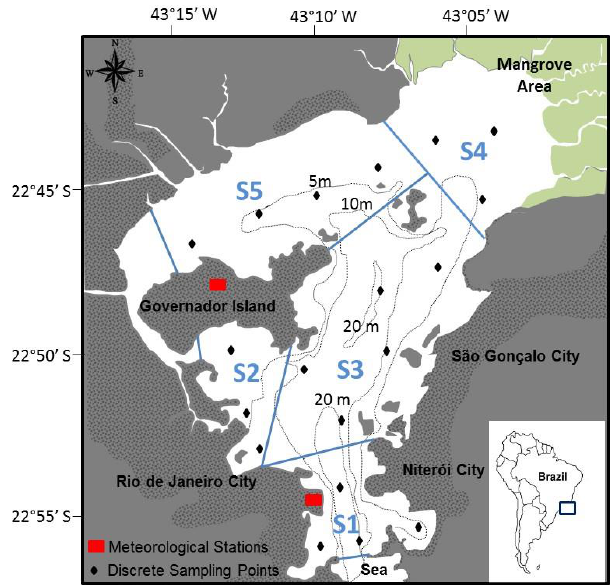
Figure 1. Map of Guanabara Bay. Dark grey indicates the urban- ized areas. Green areas represent the mangrove localization. Black points represent the locations of the discrete sampling, black lines are isobaths, red squares represent the locations of the airports with the meteorological stations, and blue lines delimit the different sec- tors in the bay (S1 to